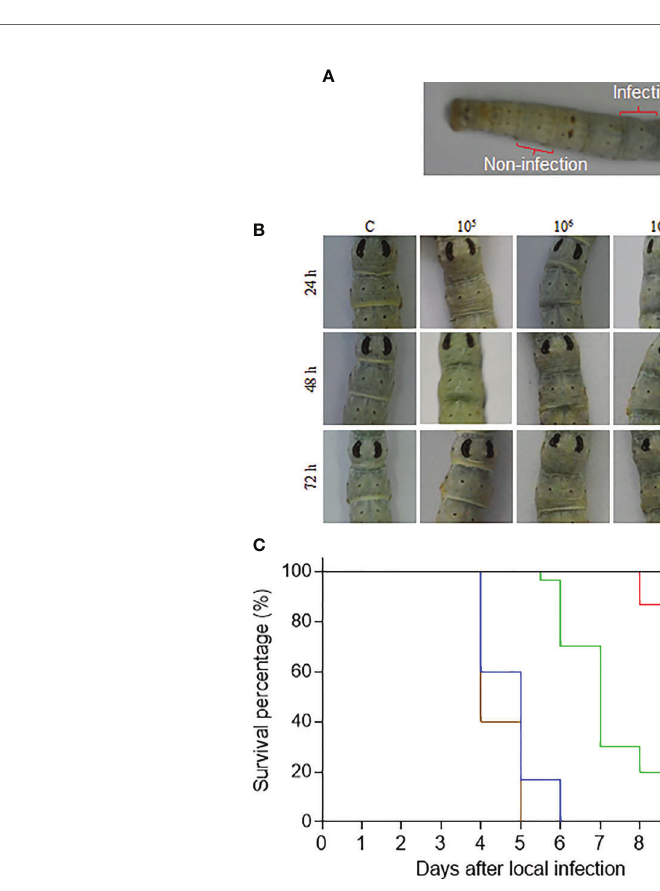
FIGURE 1 | The fi xed-site infection and its pathogenicity. (A) Development of the fi xed-site infection. The washed and dried silkworm larvae on day 1 of the 5th instar stage were used in this study. The back of the 5th segment labeled as “ Infection ” is the area (approximately 5 mm× 5 mm) for inoculation with 3 µl of conidia solution at different concentrations. The conidia solution was spread evenly. The 8th segment, which is two segments away from the infection site, is labeled as “ Non-infection ” that will be sampled as a control if necessary. (B) Morphological changes of integuments after receiving the fi xed-site infection. Conidia solutions at different concentrations were inoculated as described above. Morphological changes in the infection sites were observed and imaged at each indicated time point. (C) Bioassay after the fi xed-site infection. Conidia solution (3 µl) at a concentration of 1×10 6 -1×10 9 spores/ml was applied for fi xed-site infection individually. Conidia solution at a concentration of 1×10 8 -1×10 9 spores/ml was determined to be lethal to the larvae using the fi xed-site infection model. Please note that conidia at 1×10 8 spores/ml is usually used in a traditional infection route by submerging all larvae in a conidia solution for a period of time. Conidia at a concentration under 1×10 7 spores/ml was not pathogenic. Kaplan-Meier survival curves were compared using the log-rank (Mantel-Cox) test among each concentration of infection and control (*p < 0.05; ****p <